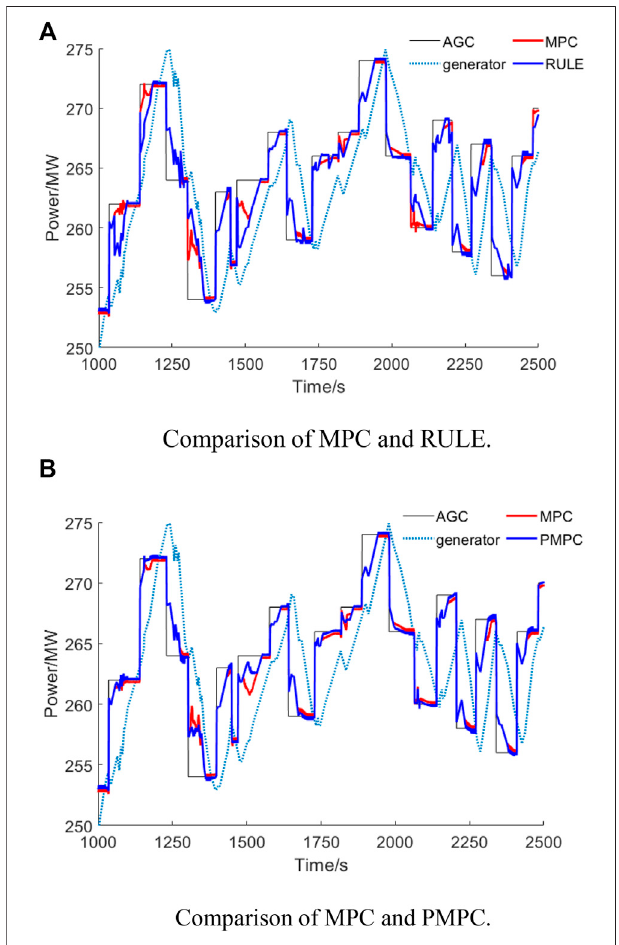
FIGURE 5 | Compensation results under different strategies. (A) Comparison of MPC and RULE. (B) Comparison of MPC and